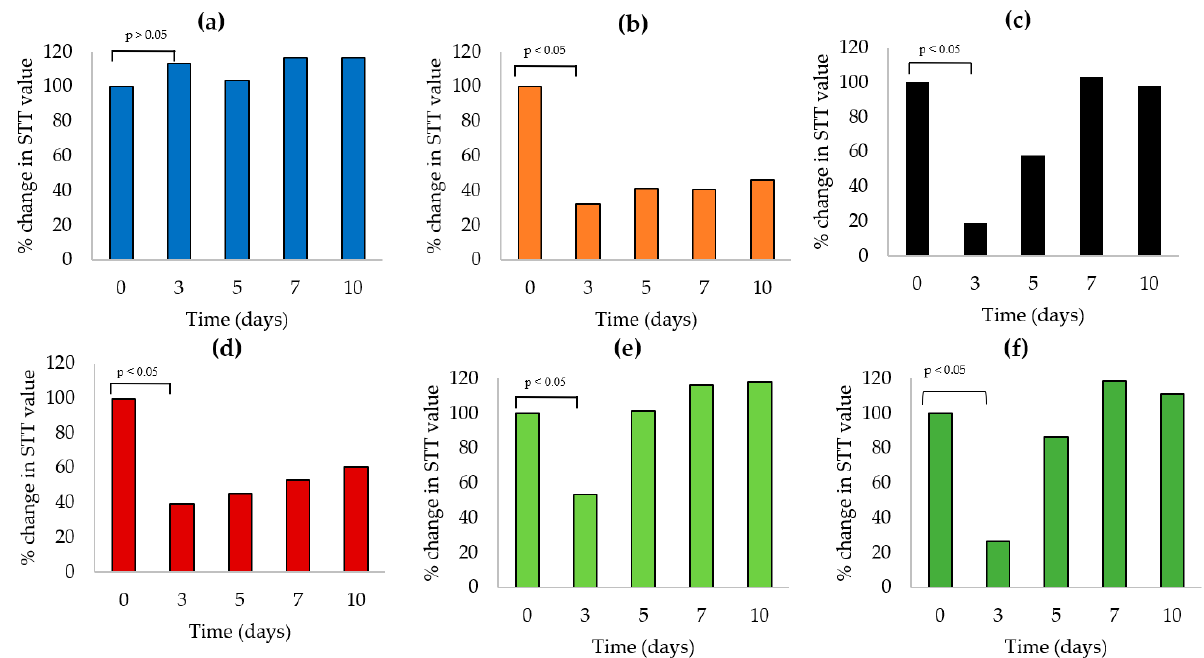
Figure 6. Change in Schirmer tear test values (day 0 values expressed as 100%), in rabbits over a 10-day period after daily instillation of ( a ) 0.9% saline only, or 1% AS and either ( b ) not treated or treated with ( c ) CsA-NE, ( d ) CsA in castor oil, ( e ) CsA-LNC-CP in situ gel (0.05% CsA), or ( f ) CsA-LNC-CP in situ gel (0.1% CsA).